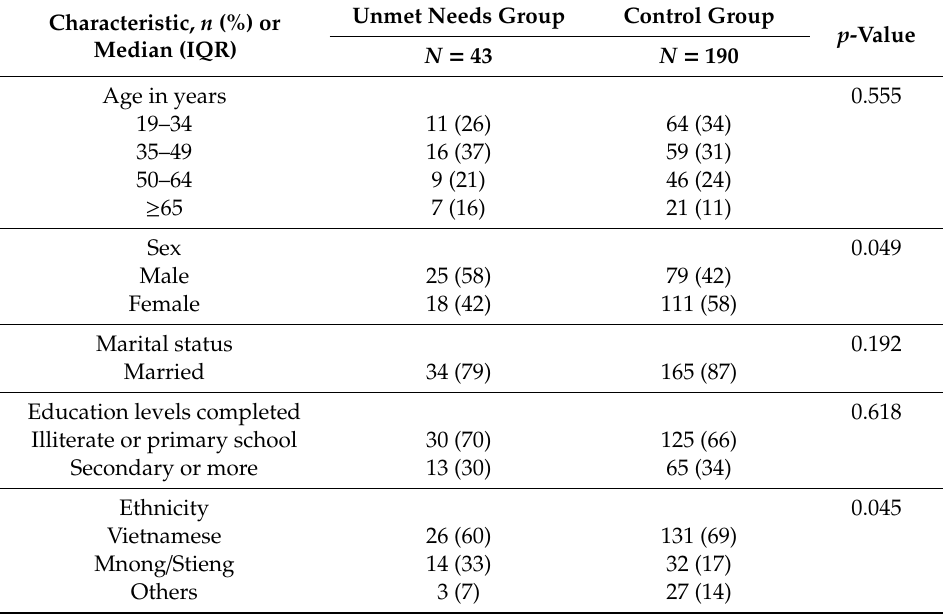
Table 1. Sociodemographic characteristics of research